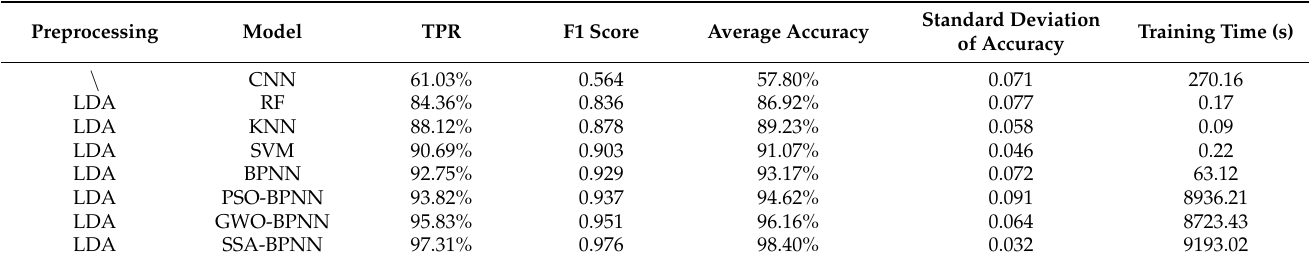
Table 5. TPR, F1 score, average accuracy, standard deviation of accuracy, and training time of different pattern recognition models by 10-fold cross-validation.